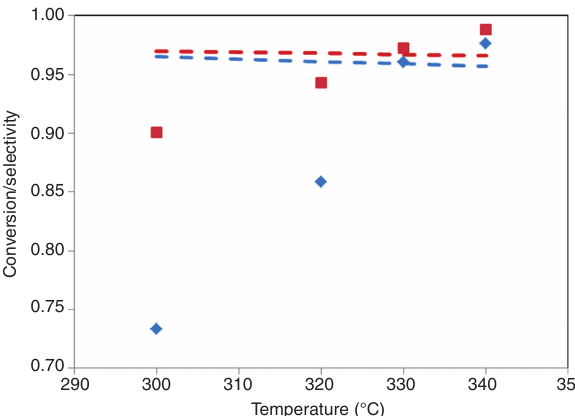
Figure 3 Influence of temperature on ( ) methanol conversion and ( ) methyl chloride selectivity. The dashed lines represent the cal- culated thermodynamic equilibrium ( ) conversion and ( ) selectivity.